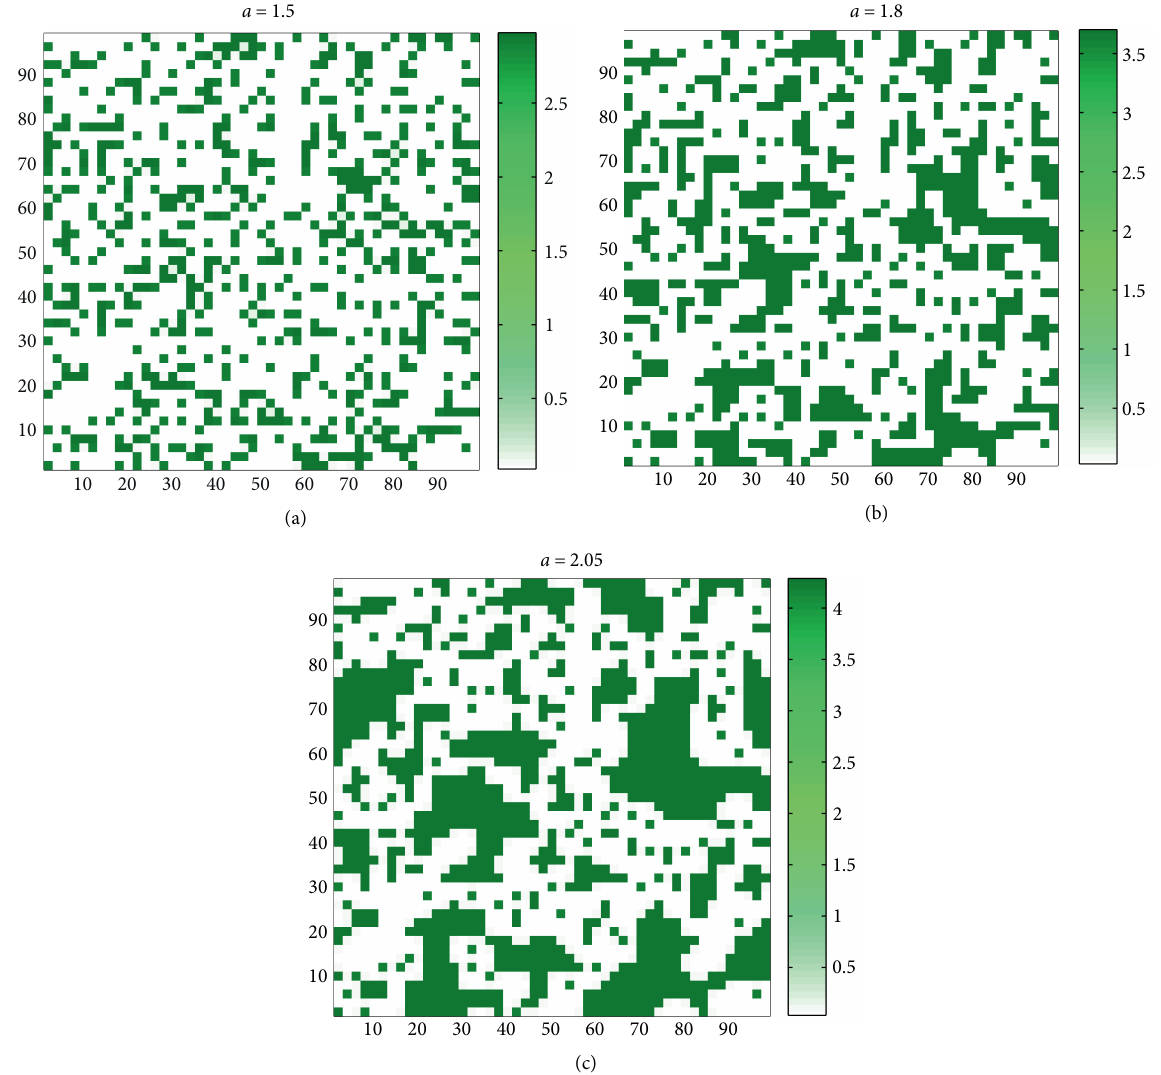
Figure 5: Patterns of irregular patches on flat ground, with application of same initial condition (IC2).